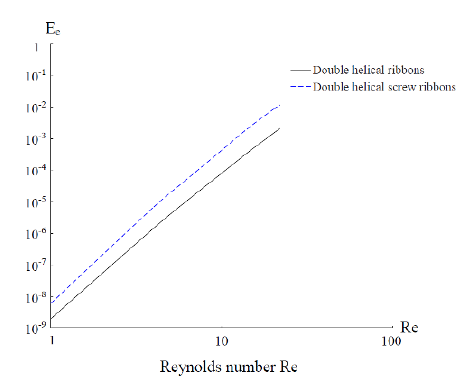
Figure 13. Pumping flow number variation NQ